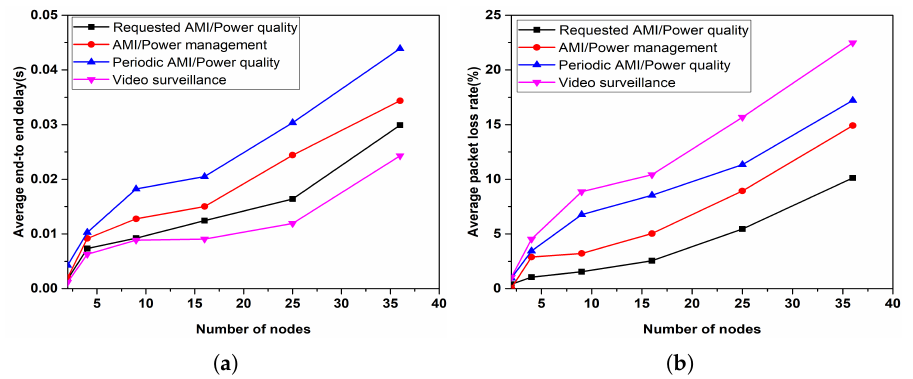
Figure 5. Performance comparison by QCORS w.r.t. different applications. ( a ) Comparison w.r.t. average delay. ( b ) Comparison w.r.t. packet